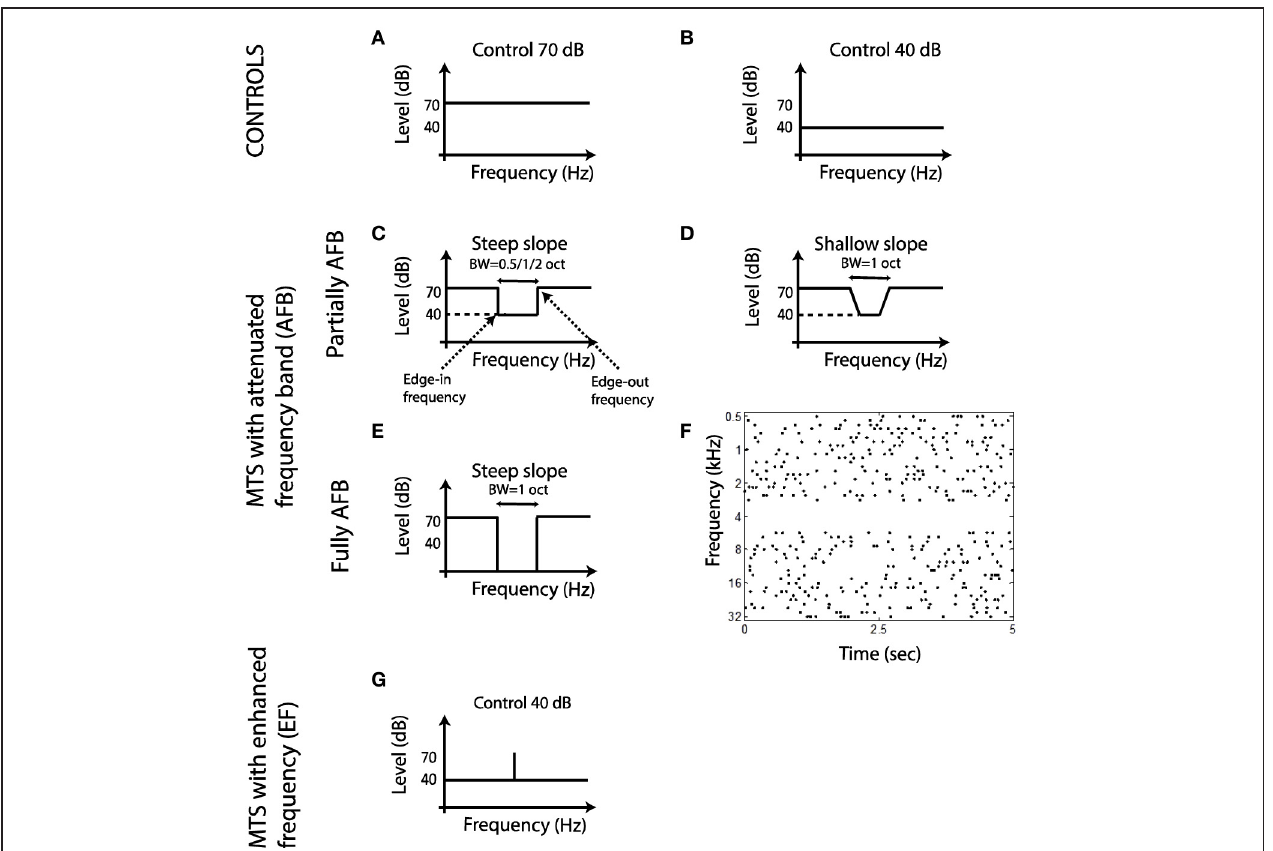
FIGURE 1 | Schematic representation of the acoustic stimuli used in the present study. (A,B) Long-term spectrum of control stimuli. (C–E) Long-term spectrum of multi-tone stimuli with an AFB. (F) Time onsets of